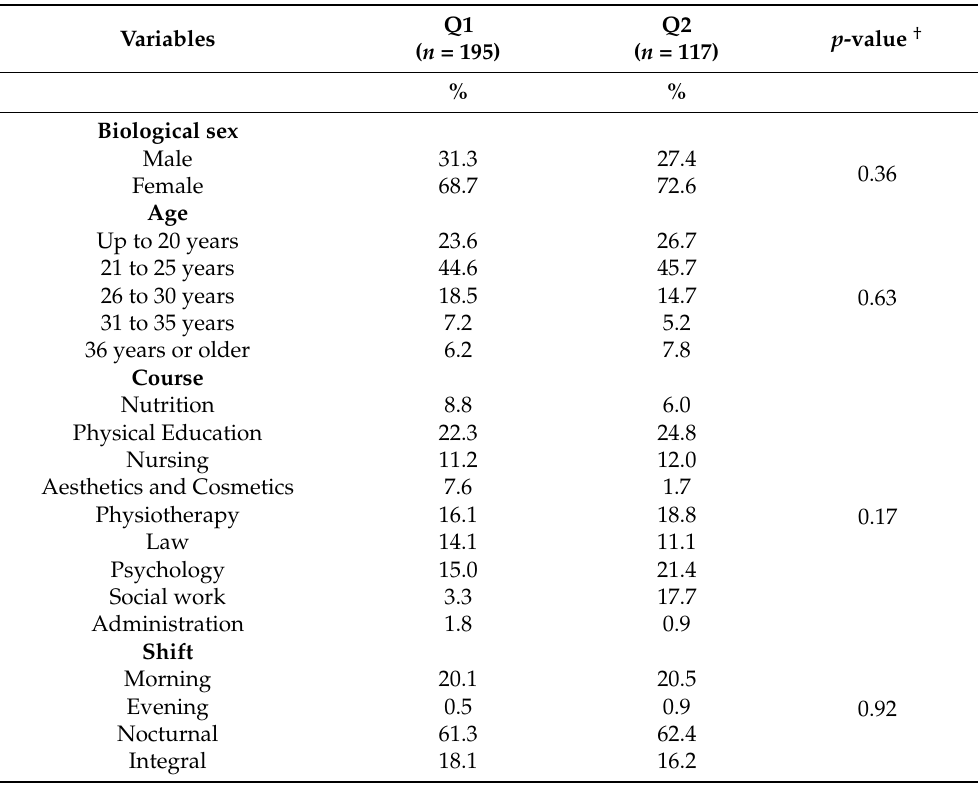
Table 1. Sensitivity analysis according to demographic and academic variables in both questionnaires, first and second